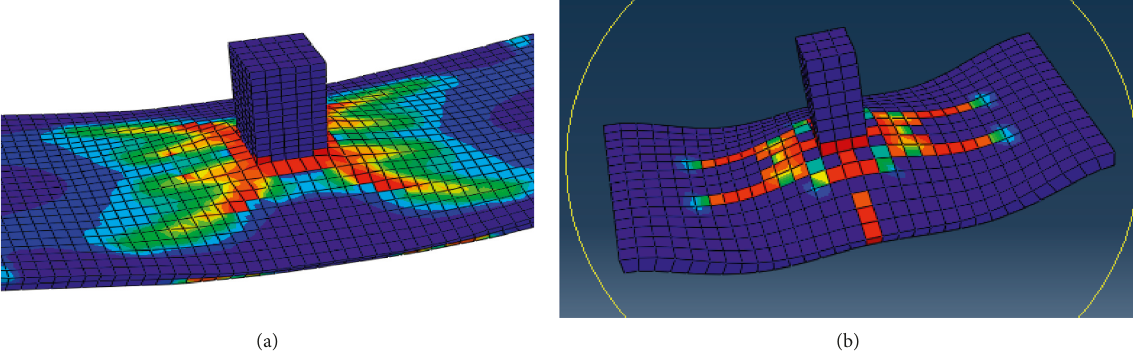
Figure 9: Cracking pattern of slab-column connection: (a) without drop panel and (b) with drop